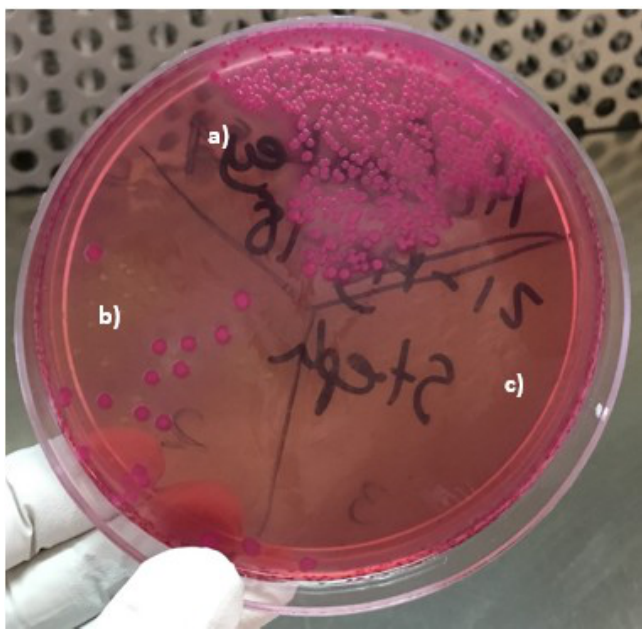
Figure 4. Photograph of plate with Escherichia coli and MacConkey agar showing the comparison of bactericidal properties. ( a ) Sample without Ag/bone system, ( b ) sample with 1% Ag/bone system, and ( c ) sample with 5% Ag/bone system.